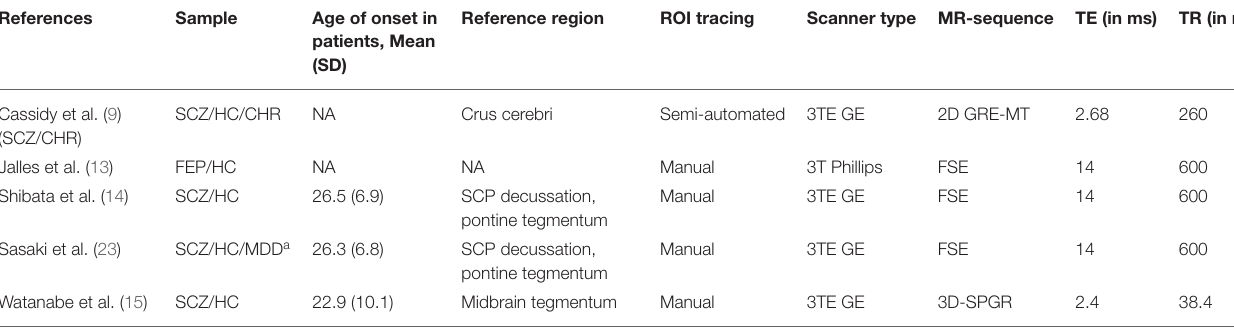
TABLE 1 | Details of MR sequences and patient